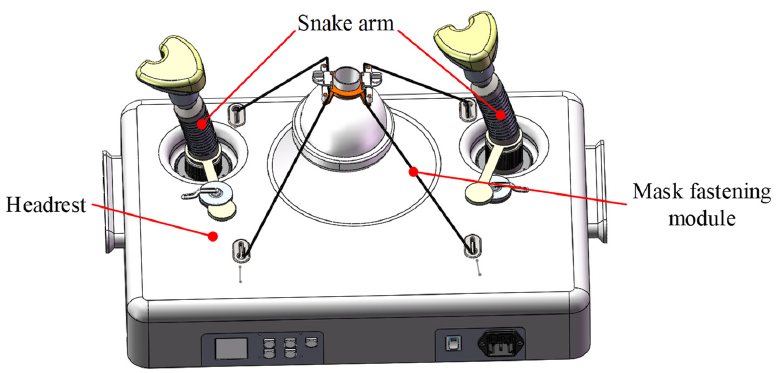
Figure 1. An overview of the proposed anesthetic airway management robot.